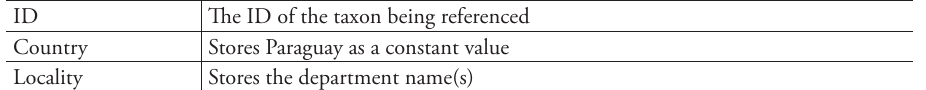
Table 2. Distribution table - One row per geographic region per taxon.